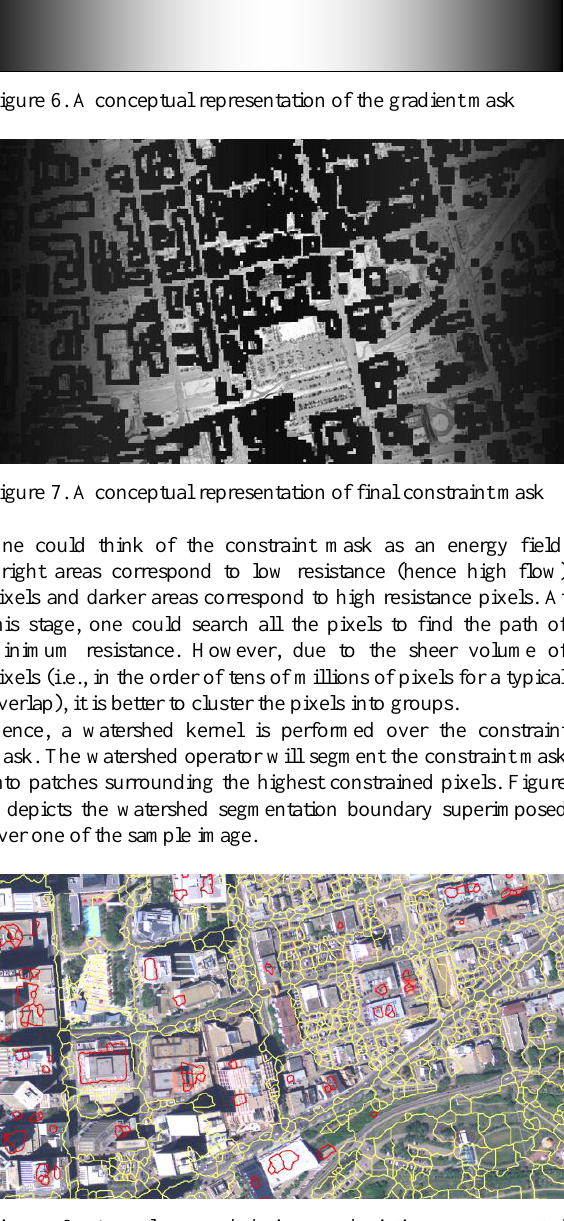
Figure 8. A colour coded image depicting a segmented constraint